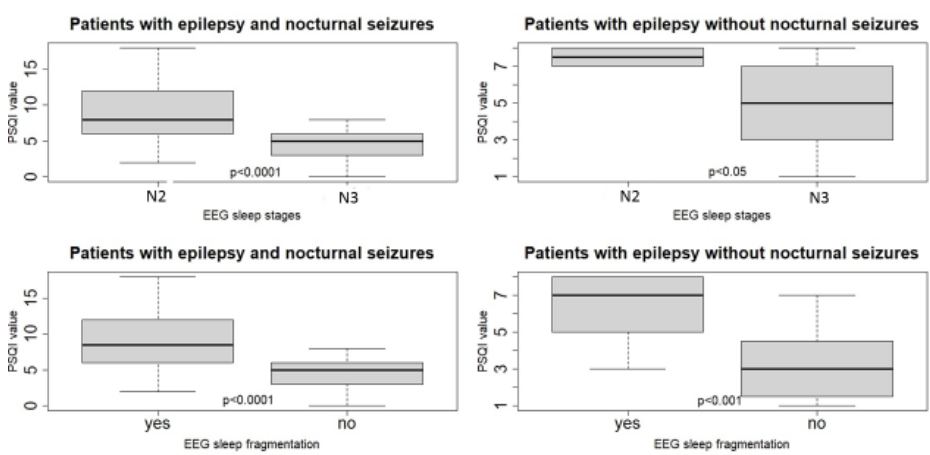
Figure 1. PSQI score distribution according to the deepest sleep stage reached. PSQI score distribution depending on sleep fragmentation by microarousals; comparison between the experimental group versus the control